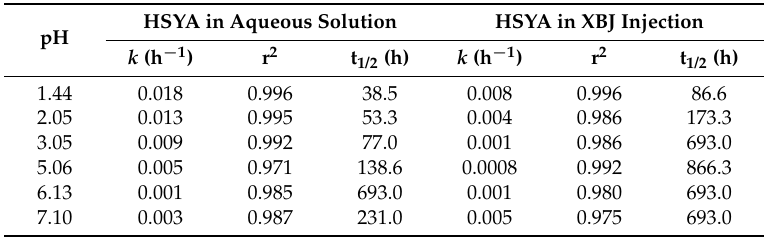
Figure 3. pH profile of k of HSYA degradation at 25 °C in aqueous solution and XBJ injection. Table 1. Kinetic parameters of the hydrolysis of HSYA at 25 °C.